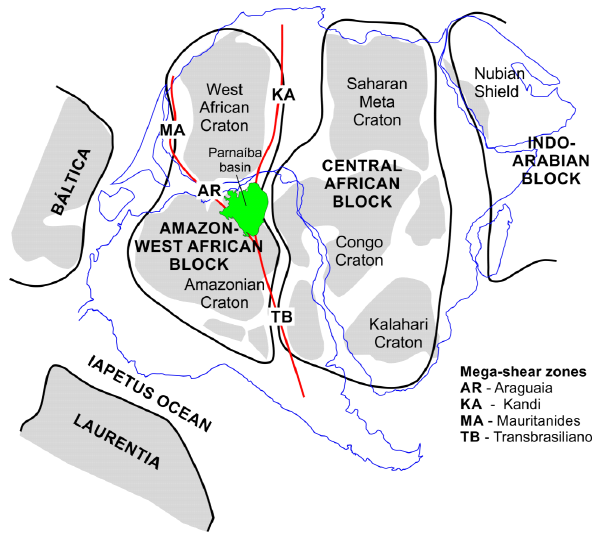
Figure 1. Reconstruction of West Gondwana at ca. 540Ma, show- ing major crustal domains and continental shear zones discussed in the text. Key: red lines represent shear zones; blue lines repre- sent continents; thick black lines represent West Gondwana conti- nental blocks. Adapted from Cordani et al. (2013) and Stampfli et al.